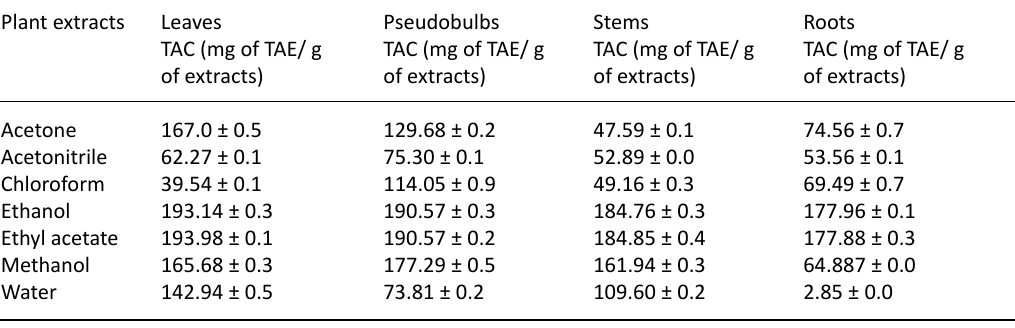
table 4. Total antioxidant capacity (TAC) of P. maculata by Phosphomolybdenum assay Plant extracts